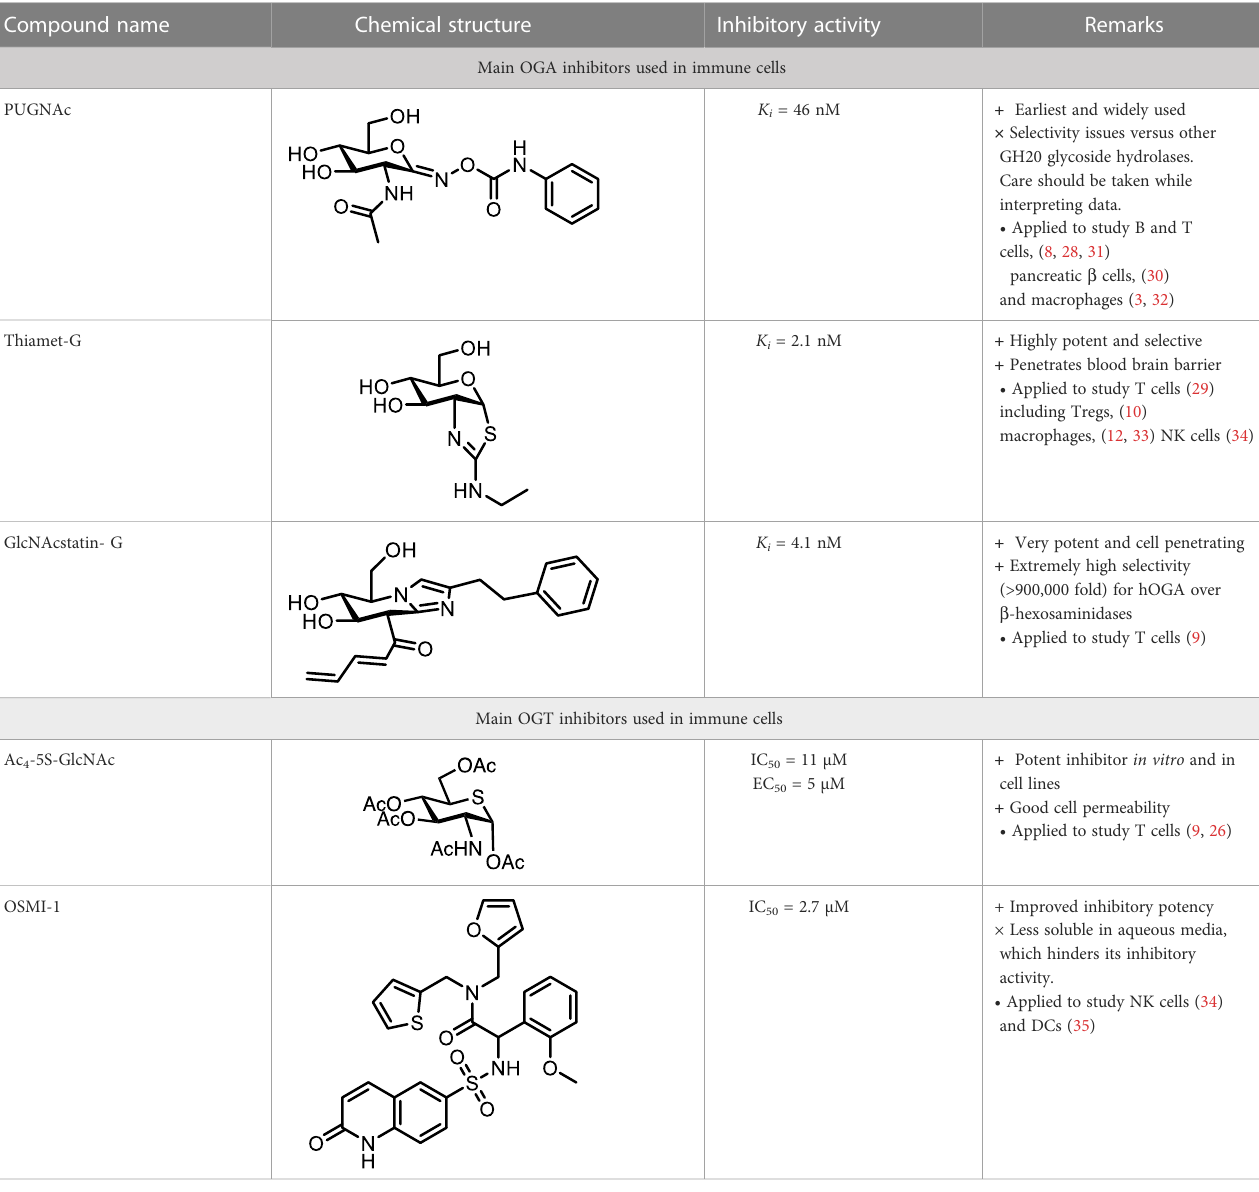
TABLE 1 OGA and OGT inhibitors used in studies connecting O -GlcNAc and its role in